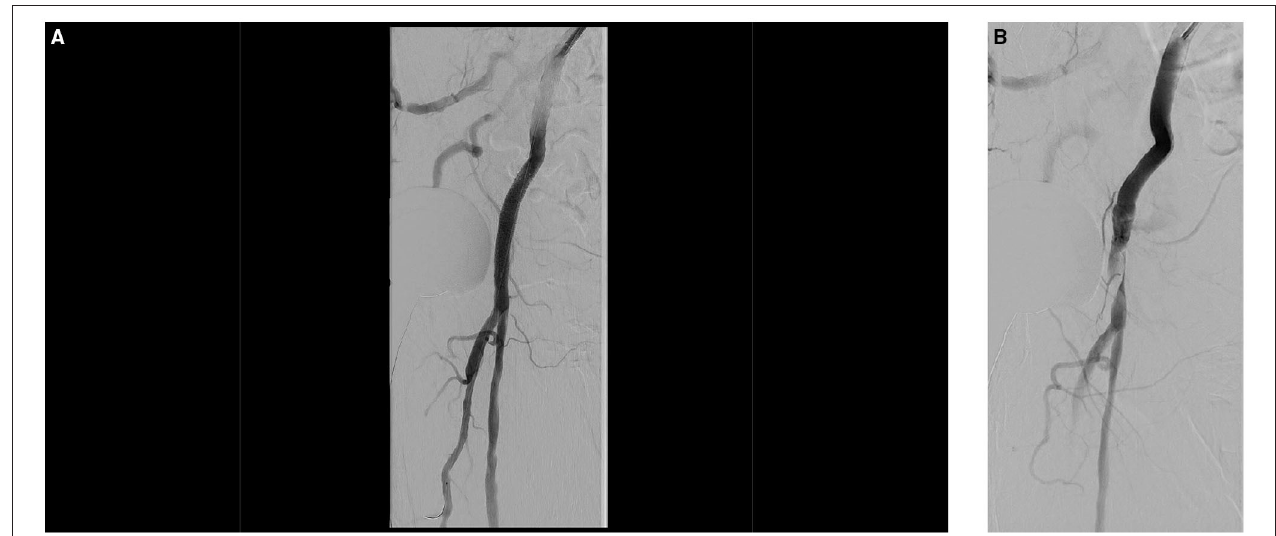
FIGURE 4 | The valve was implanted without any complications (26mm Evolut R, Medtronic), using a 14F sheath on the right and a 6F sheath on the left side. Access to the right femoral artery was closed using two previously administered Perclose ProGlide TM (Abbott) systems. Control angiography showed delayed contrast flow in the right ileofemoral axis and was therefore suggestive for an acute occlusion of the right femoral artery. The crossover angiogram confirmed a femoral artery occlusion and, in addition, a small bleeding (A) . Left femoral sheath was changed to 6F 45cm (Fortress ® , Biotronik) sheath. Occlusion was passed with a 0.0018-inch wire (Glidewire Advantage ® , Terumo) and dilated using a 4.0 × 40mm balloon (Passeo-18, Biotronik). Subsequently, we implanted an 8.0 × 50mm covered stent prothesis (Gore ® Viabahn ® Endoprosthesis, Gore). Due to the necessity of implanting a stent in the highly flexible femoral artery we decided us to stabilize this by implantation of an interwoven 7.5 × 40mm stent (Supera TM Stent, Abbott). Final angiography displayed a very good result (B)